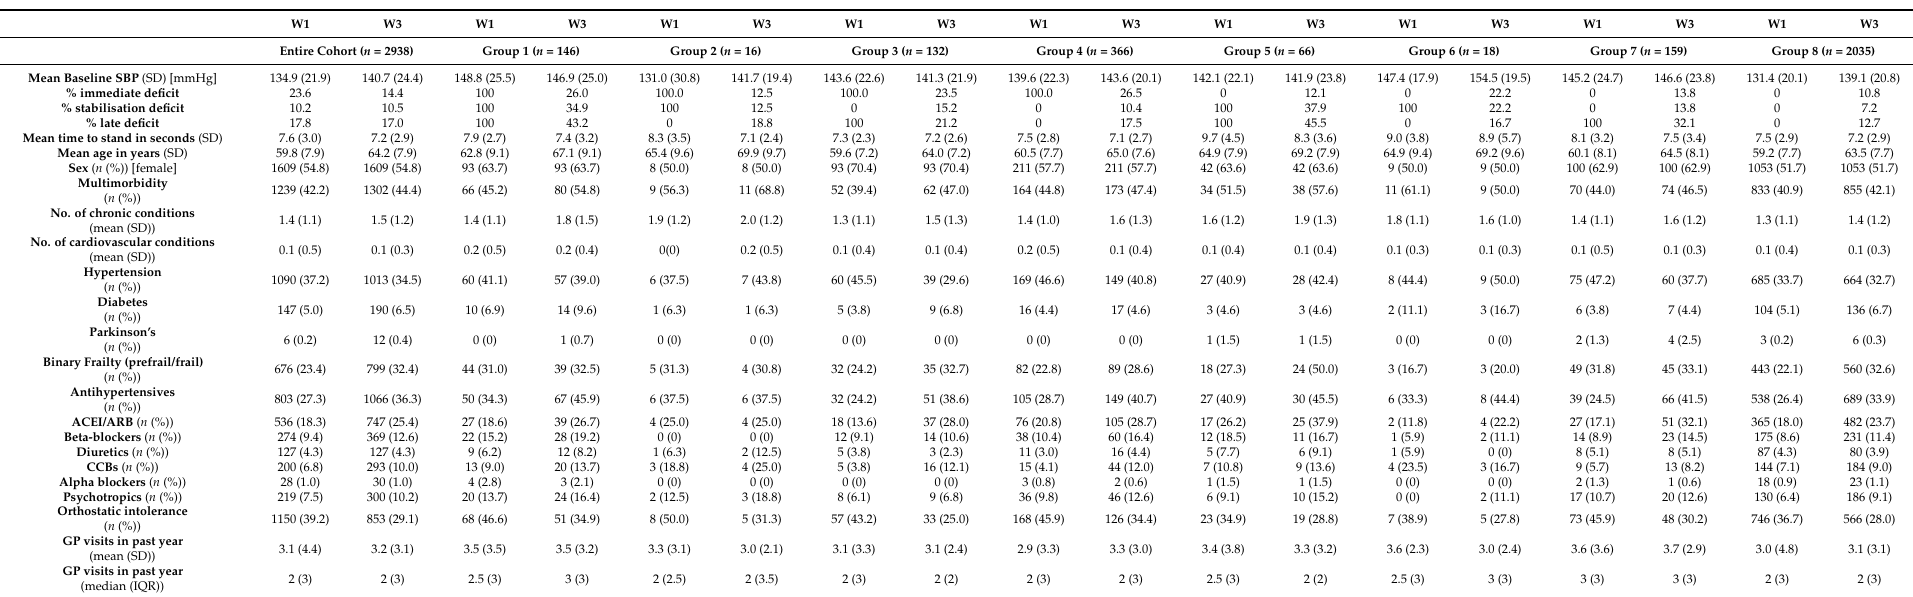
Table 1. Characterisation of the overall sample and the eight active stand groups at Wave 1 and Wave 3.